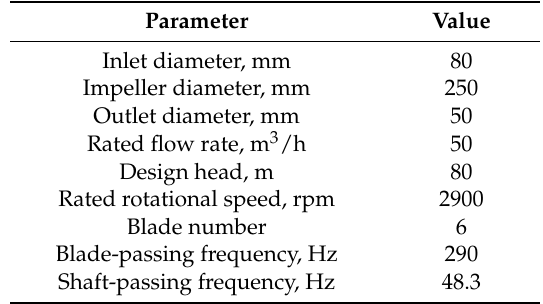
Table 1. Geometric and performance parameters of the test pump.